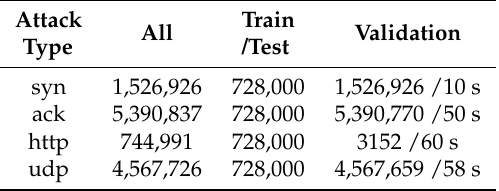
Table 6. Train/Test/Validate traffic proportion in the Mirai-RGU dataset.